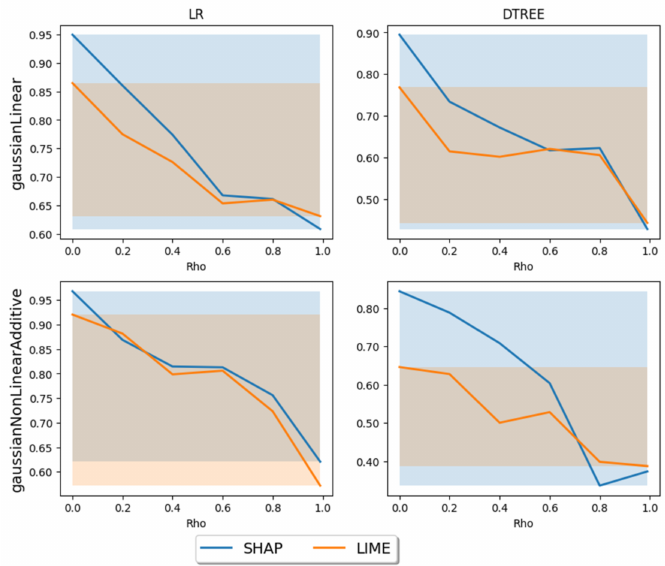
Figure 4. Dependence of the reliability metric on the correlation